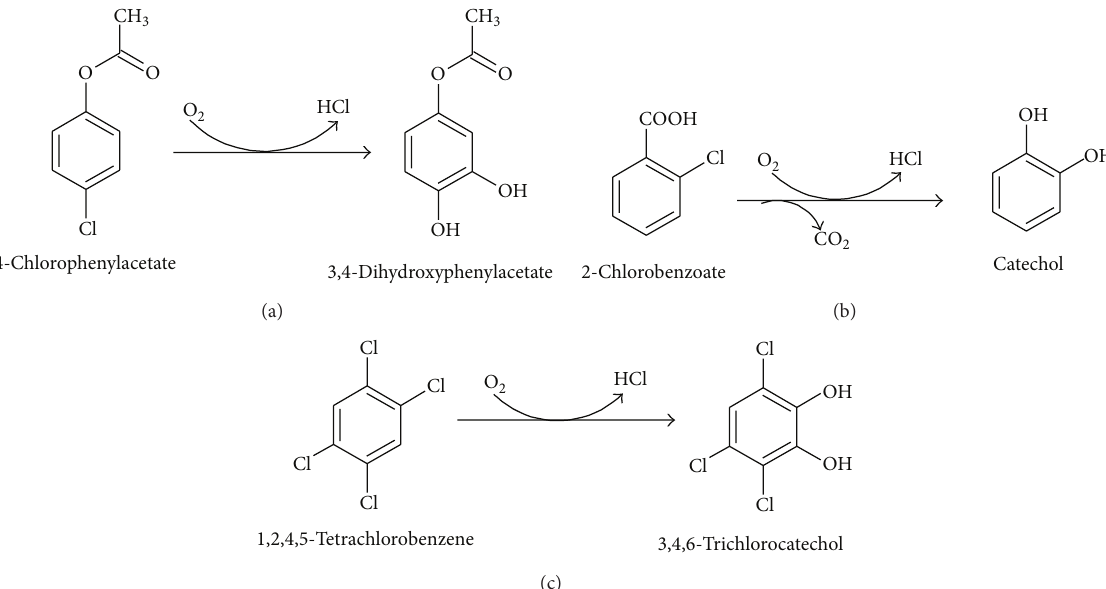
Figure 4: Dioxygenase type dehalogenation of (a) 4-chlorophenylacetate by 4-chlorophenylacetate-3,4-dioxygenase; (b) 2-chlorobenzoate by a halobenzoate dehalogenase and (c) 1,2,4,5-tetrachlorobenzene by a chlorobenzene